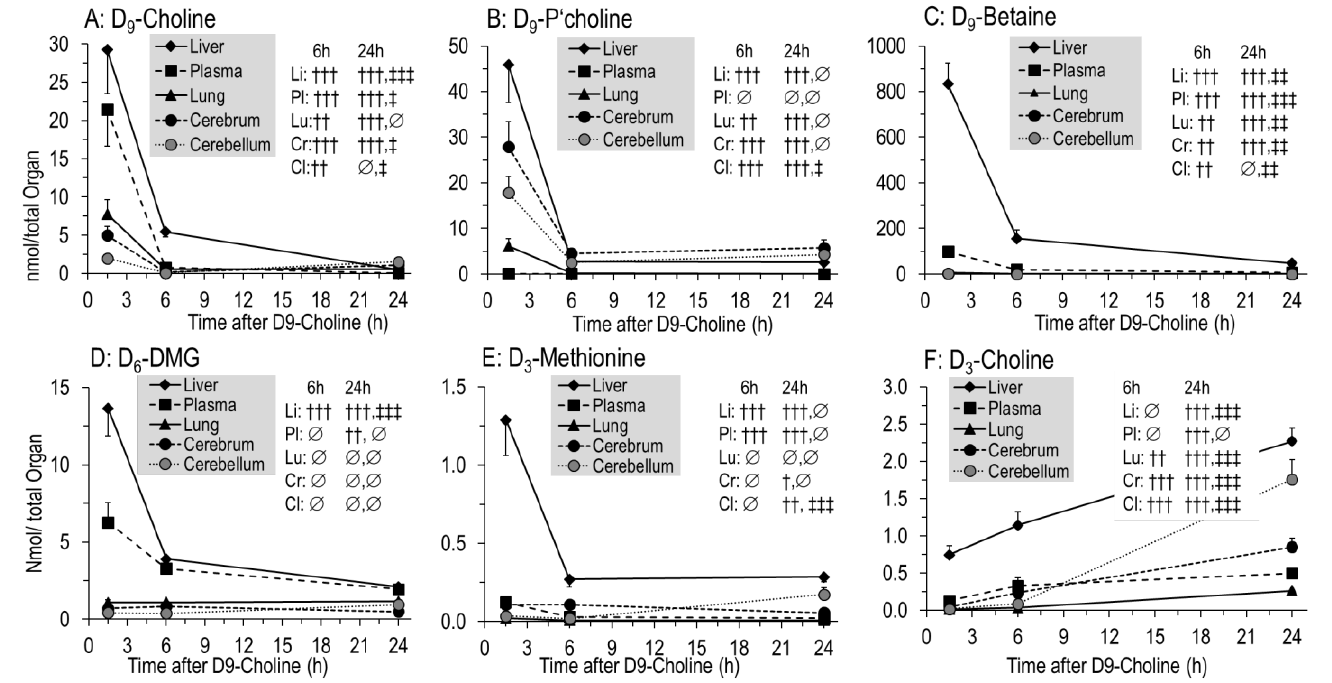
Figure 3. Kinetics of D9-choline ( A ) and its deuterated water-soluble metabolites ( B – F ) in individual organs. Data are expressed as total pools of compounds in individual organs and total plasma volume and are means ± SE of 8–10 data points per time point (1.5 h, 6 h, 24 h) after intraperitoneal injection of 50 mg/kg D9-choline chloride. Abbreviations: ∅ , not significant; †, p < 0.05, ††, p < 0.01, †††, p < 0.001 vs. 1.5 h; ‡, p < 0.05, ‡‡, p < 0.01, ‡‡‡, p < 0.001 vs. 6 h.